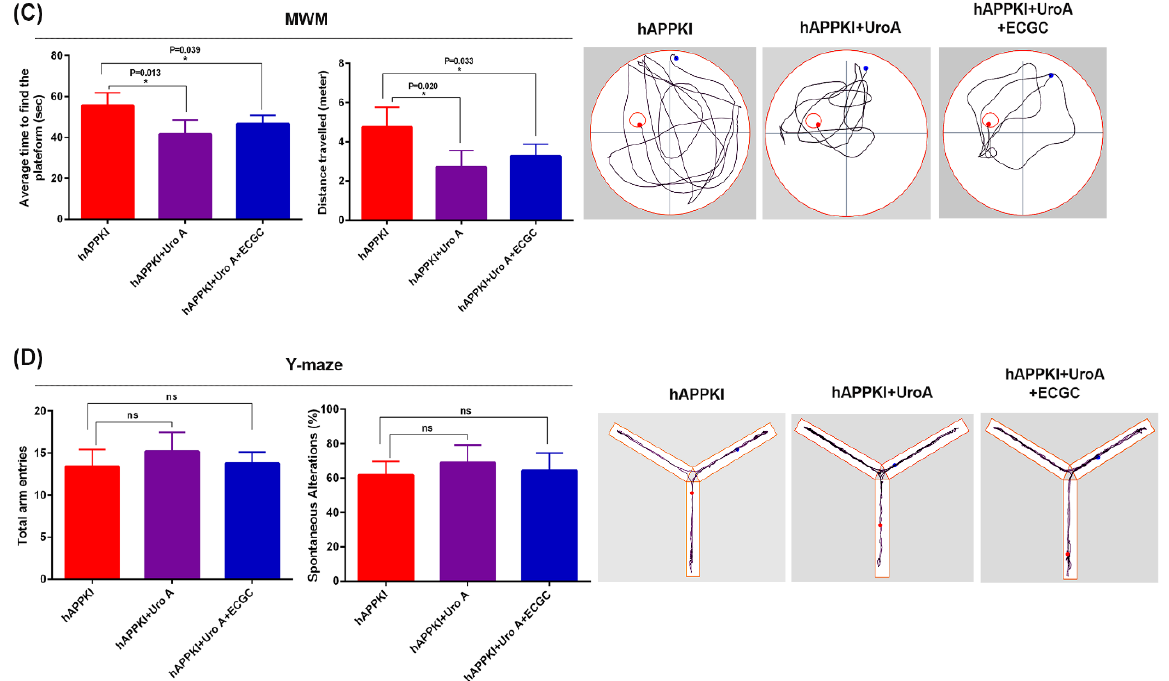
Figure 2. Cognitive behavior of seven-month-old hAbKI and hAbKI mice treated with Urolithin A and EGCG. Phenotypic behavior is evaluated using rotarod for motor coordination, open field for locomotor activity/exploration abilities, Y-maze for working memory and Morris water maze for spatial learning and memory in seven-month-old hAbKI mice and hAbKI mice treated with Urolithin A and EGCG. ( A ) On an accelerating rotarod test, hAbKI mice did not stay longer compared to treated mice with Urolithin A and EGCG. ( B ) In open field, hAbKI mice showed reduced total distance traveled and average speed compared to treated mice. ( C ) In the Morris water maze test, hAbKI mice showed an increased time to find the platform, and increased distance traveled compared with treated mice. ( D ) In the Y-Maze test the total number of arm entries was significantly reduced and the percentage of spontaneous alternation between the arms of the Y-maze was significantly decreased for seven-month-old hAbKI compared treated mice.